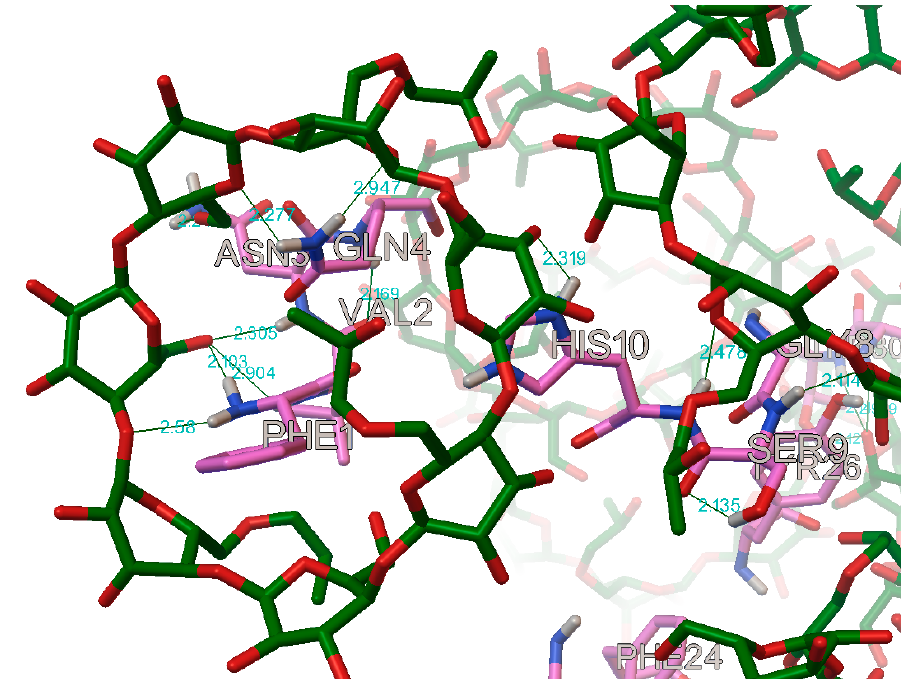
Figure 17. The most commonly occurring hydrogen bonds on the first part of the B chain in the insulin molecule (in this case with the hydroxypropyl- β -cyclodextrin, DS 2).